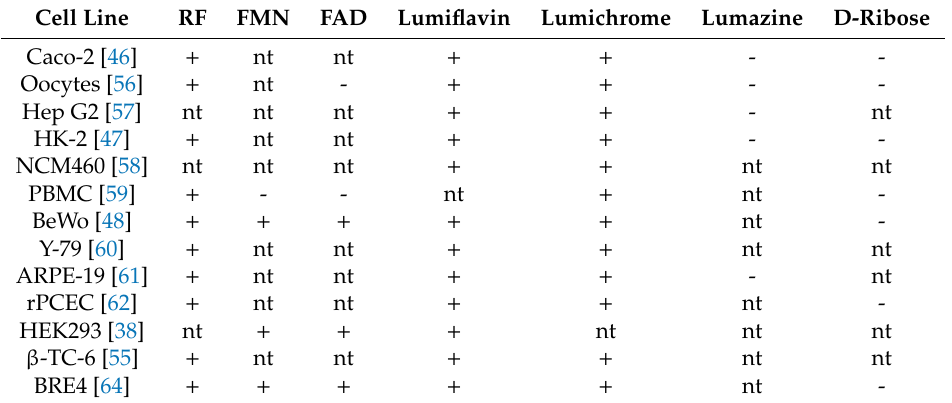
Table 2. E ff ects of pre-treatment with competing structures on riboflavin uptake. Cell Line